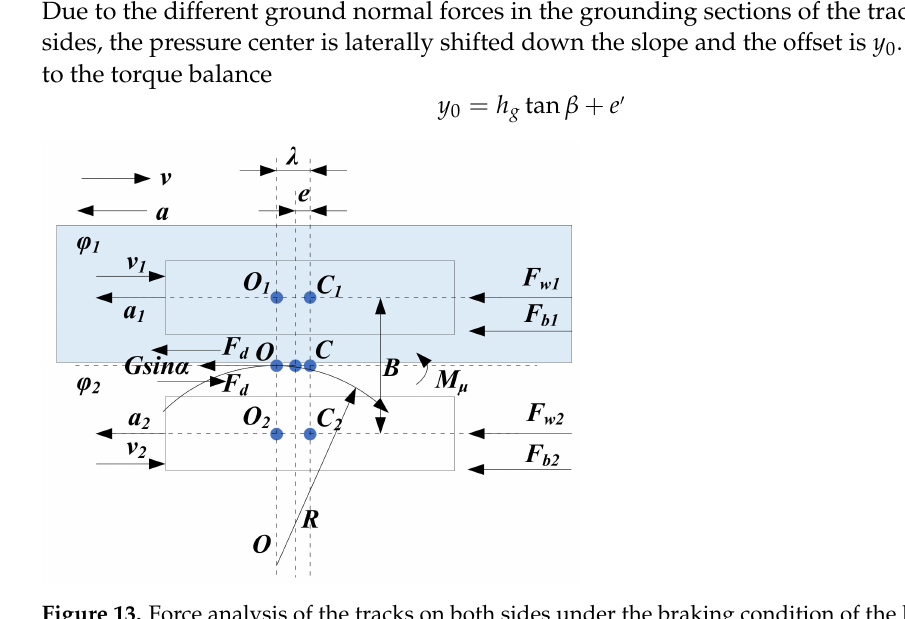
Figure 13. Force analysis of the tracks on both sides under the braking condition of the longitudinal split road.